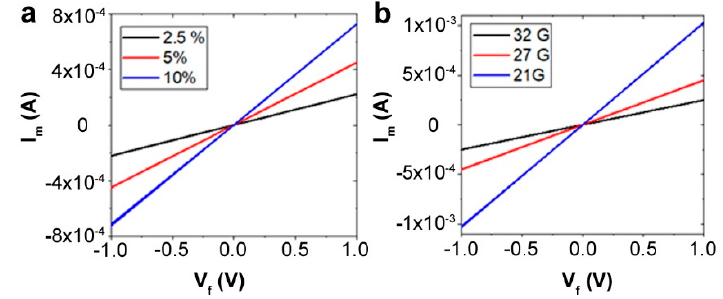
Figure 2. ( a ) Current-Voltage (I–V) curves of PEDOT:PSS fibers spun using different concentrations of PEDOT:PSS. At higher concentrations, the resistance is lower. ( b ) I–V behavior as a function of the needle diameter for the same concentration of PEDOT:PSS (5%).